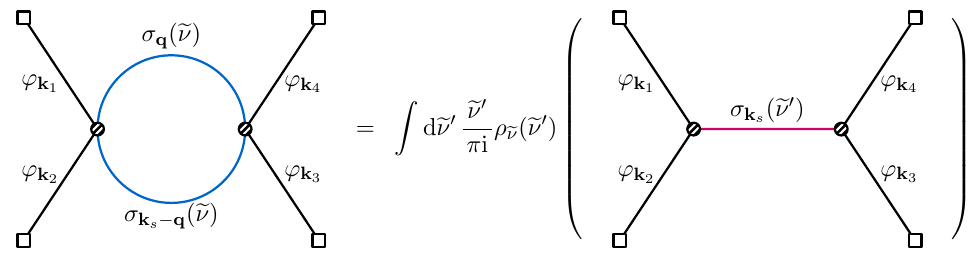
Figure 1 . Computing 1-loop inflation correlator via spectral decomposition. The diagrammatic notation follows